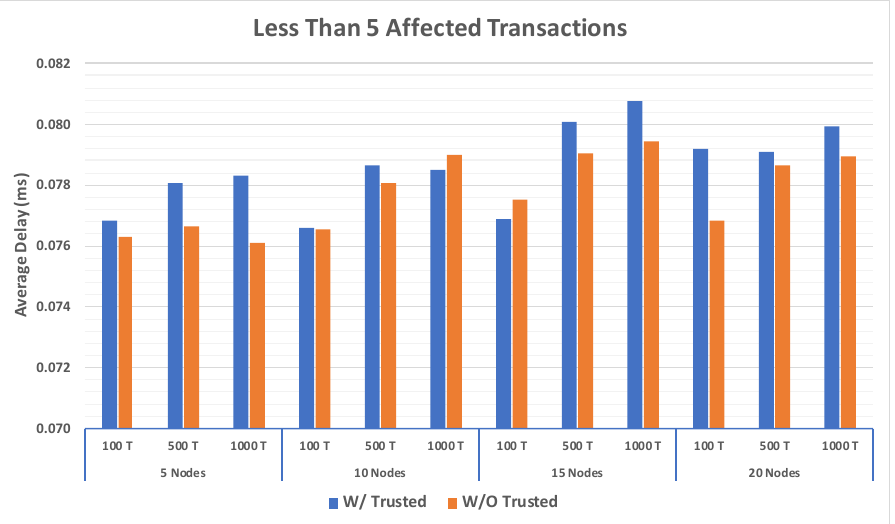
Figure 10. Comparison between having global graph on trusted fog node and not on a set of less than five affected transactions.